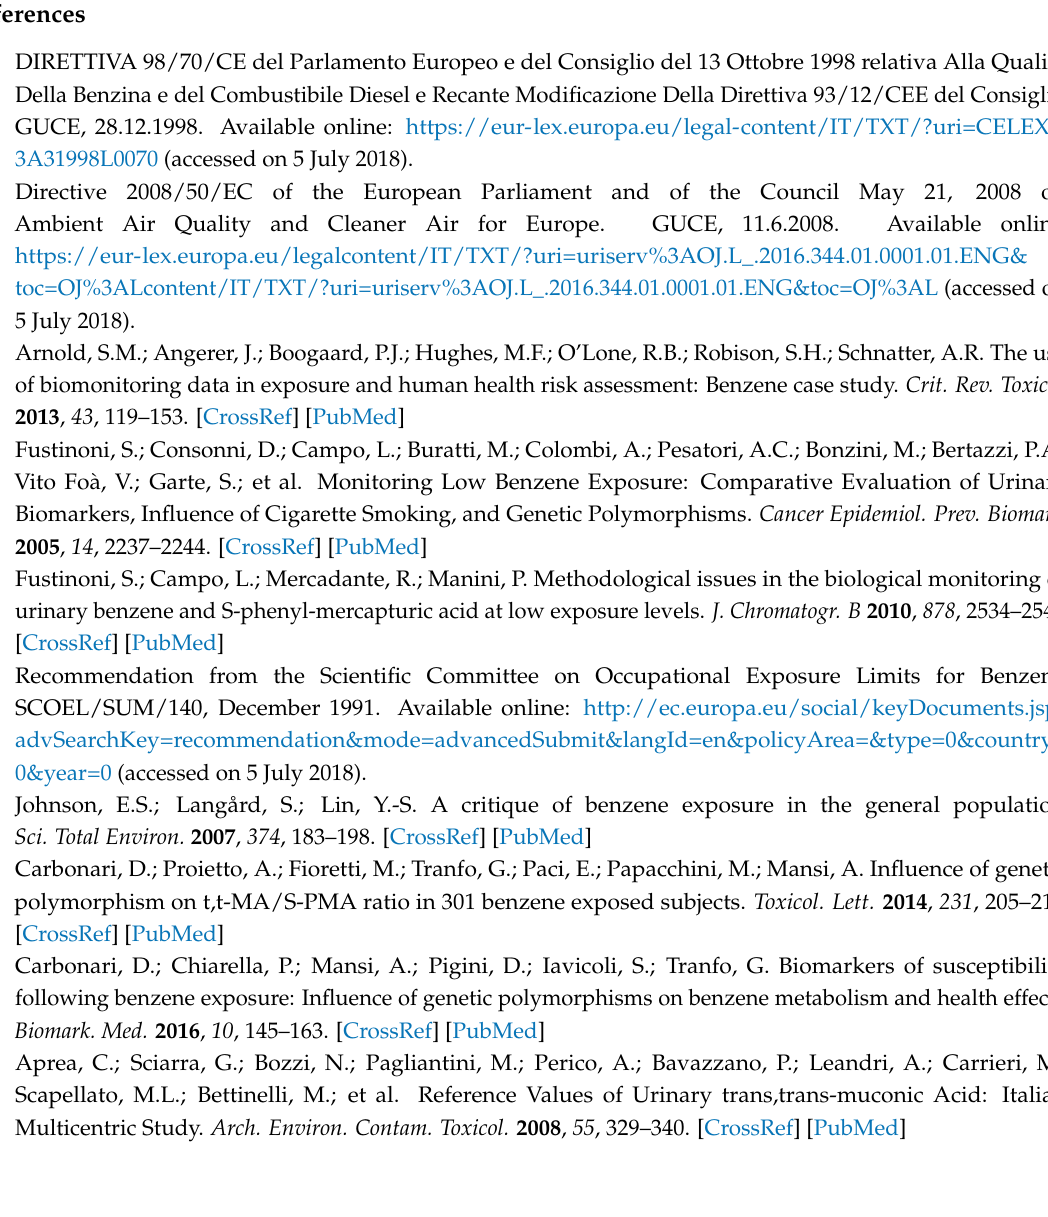
Table S1. Urinary SPMA concentrations ( µ g/L); Table S2. Summary of the population studies published from year 2011; Table S3. Summary of the occupational exposure studies published from year 2011 (data of